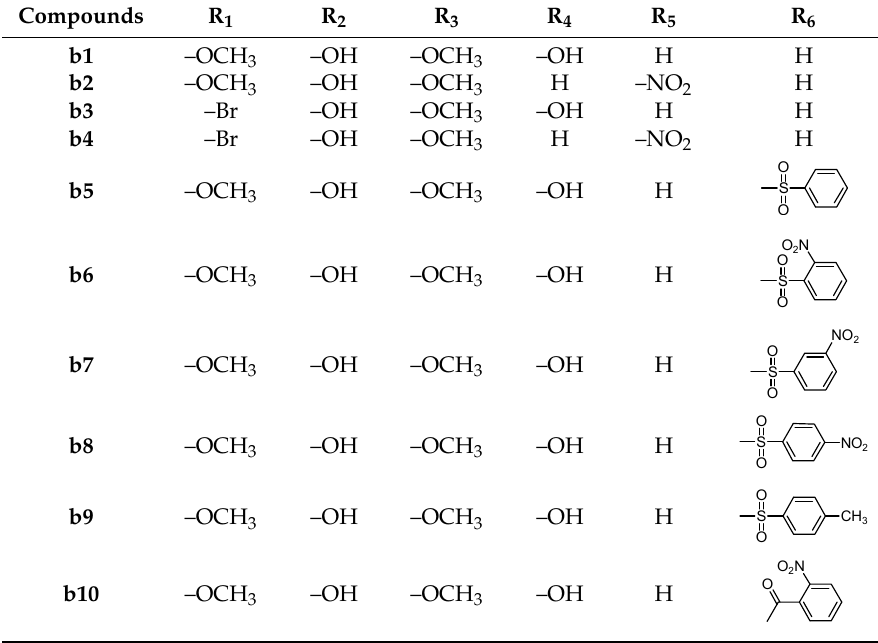
Table 2. Structure of the compounds b1 – 19 .